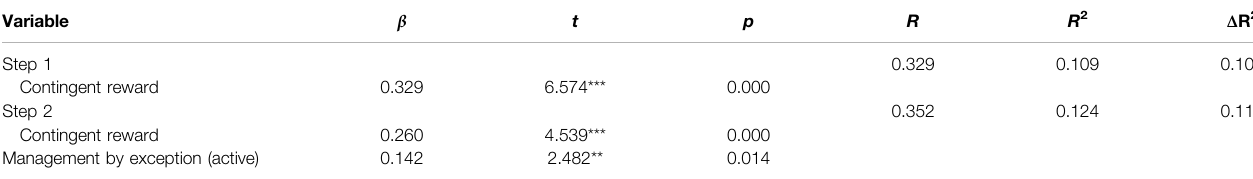
TABLE 1 | Summary of hierarchical regression analysis for variables predicting motivation for the evaluation of students. Variable β